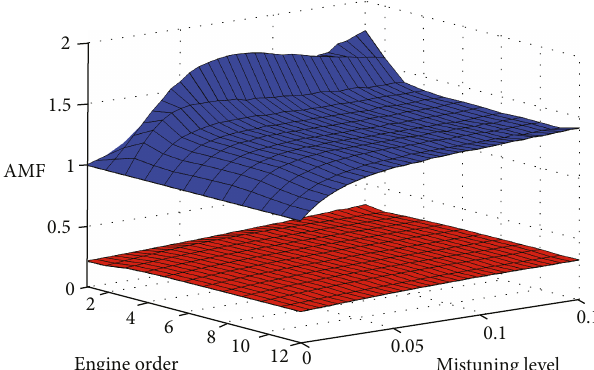
Figure 11: Estimations of AMF for the mistuned blisk with (red) and without (blue) SSDNC.